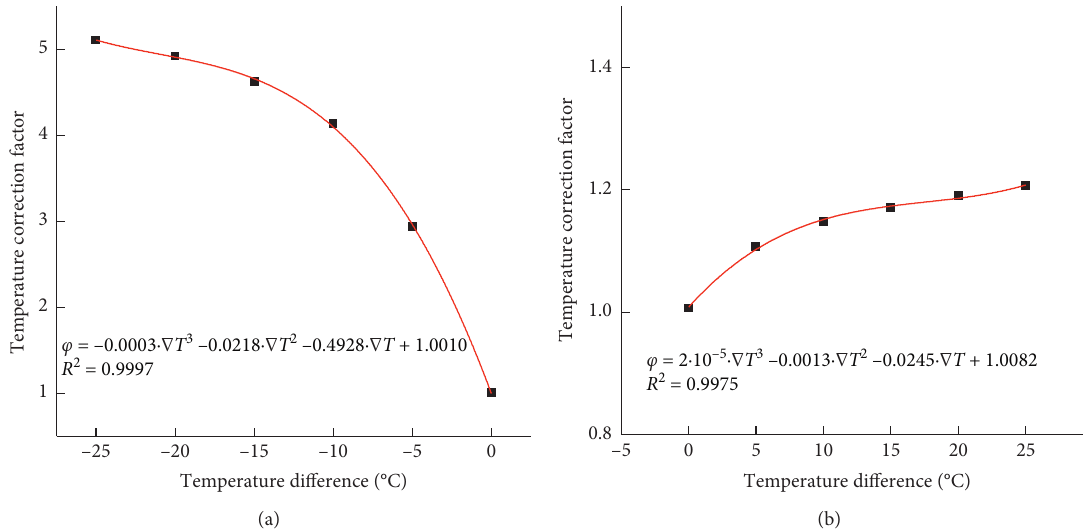
Figure 9: Correlation between positive and negative temperature differentials and correction coefficient. (a) Negative temperature range. (b) Positive temperature